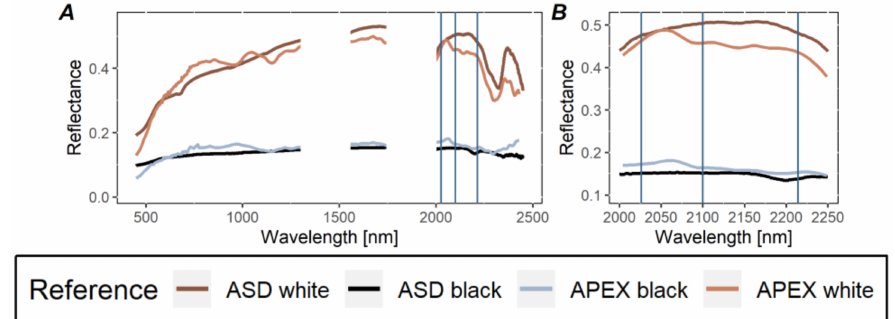
Figure 5. ( A ) Visible (Vis), near-infrared (NIR) and shortwave infrared (SWIR) (VNIR-SWIR) reflectance spectra of black and white references recorded by the ASD pro FR portable spectroradiometer and by the Airborne Prism Experiment (APEX) sensor; ( B ) zoom on the SWIR region where the soil spectra are the most a ff ected by crop residues. The three vertical lines correspond to the cellulose absorption index wavelengths used in this study (R 2.0 = 2026 nm, R 2.1 = 2100 nm, R 2.2 = 2214